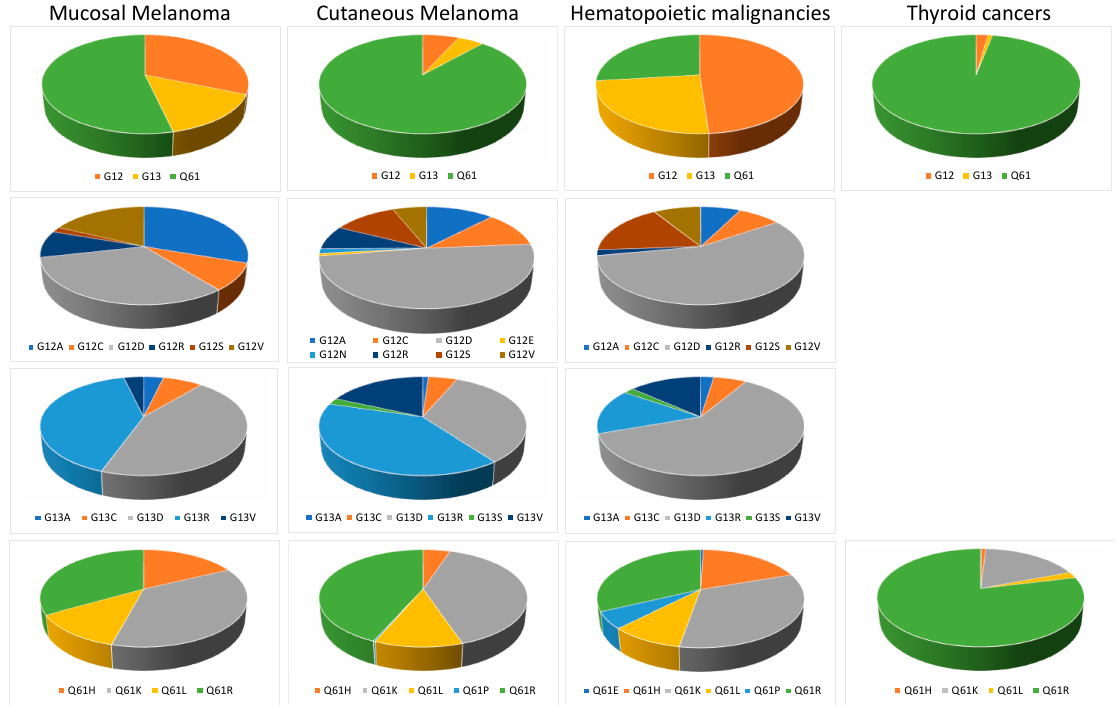
Figure 2. Oncogenic mutations of NRAS on glycine 12 (G12), 13 (G13), and glutamine 61 (Q61) collated from the literature (mucosal melanoma; Table S1) or from COSMIC (cutaneous melanoma, hematopoietic malignancies and thyroid cancers).